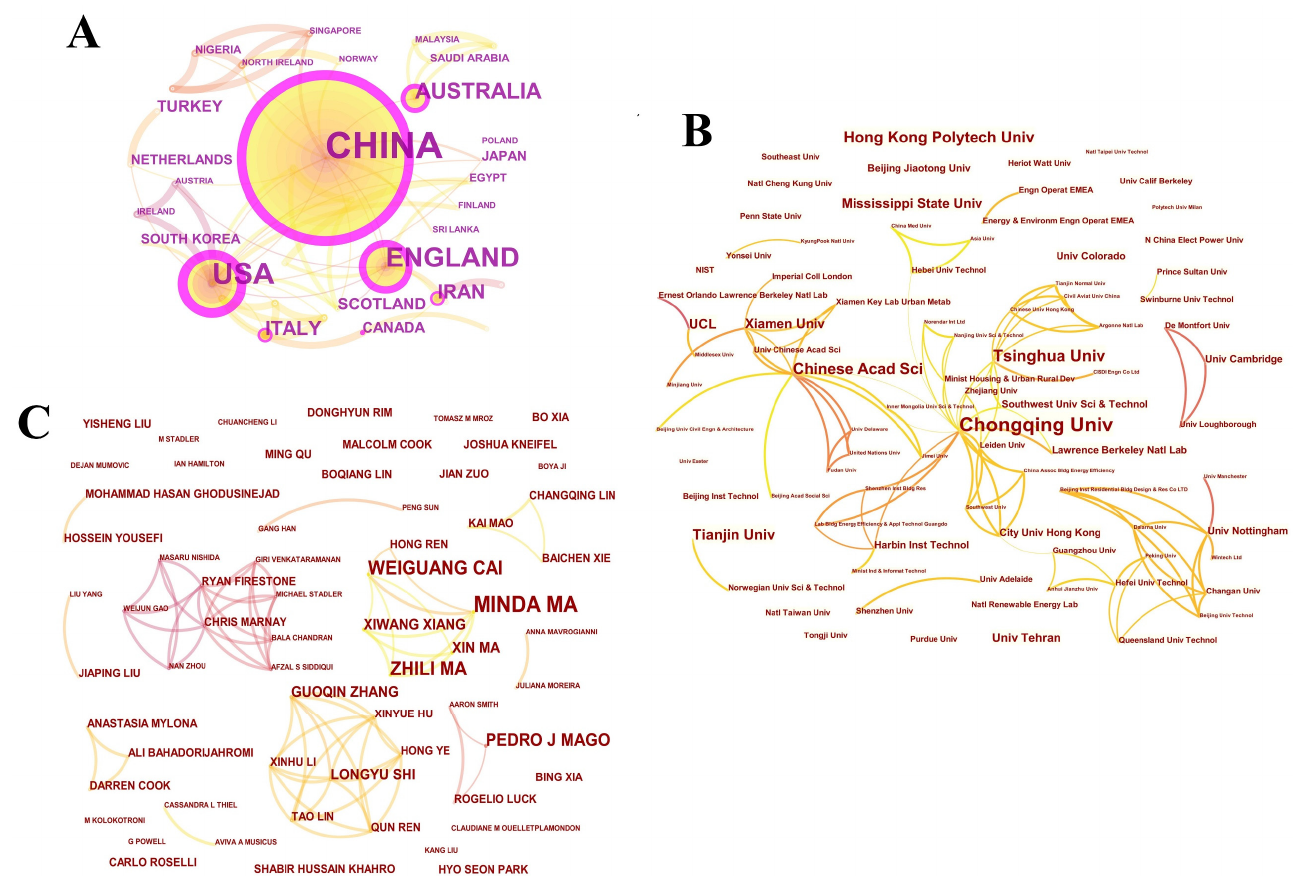
Figure 3. Visualization of the co-countryship and co-regionship ( A ), co-institution ( B ), co-authorship ( C ) network.